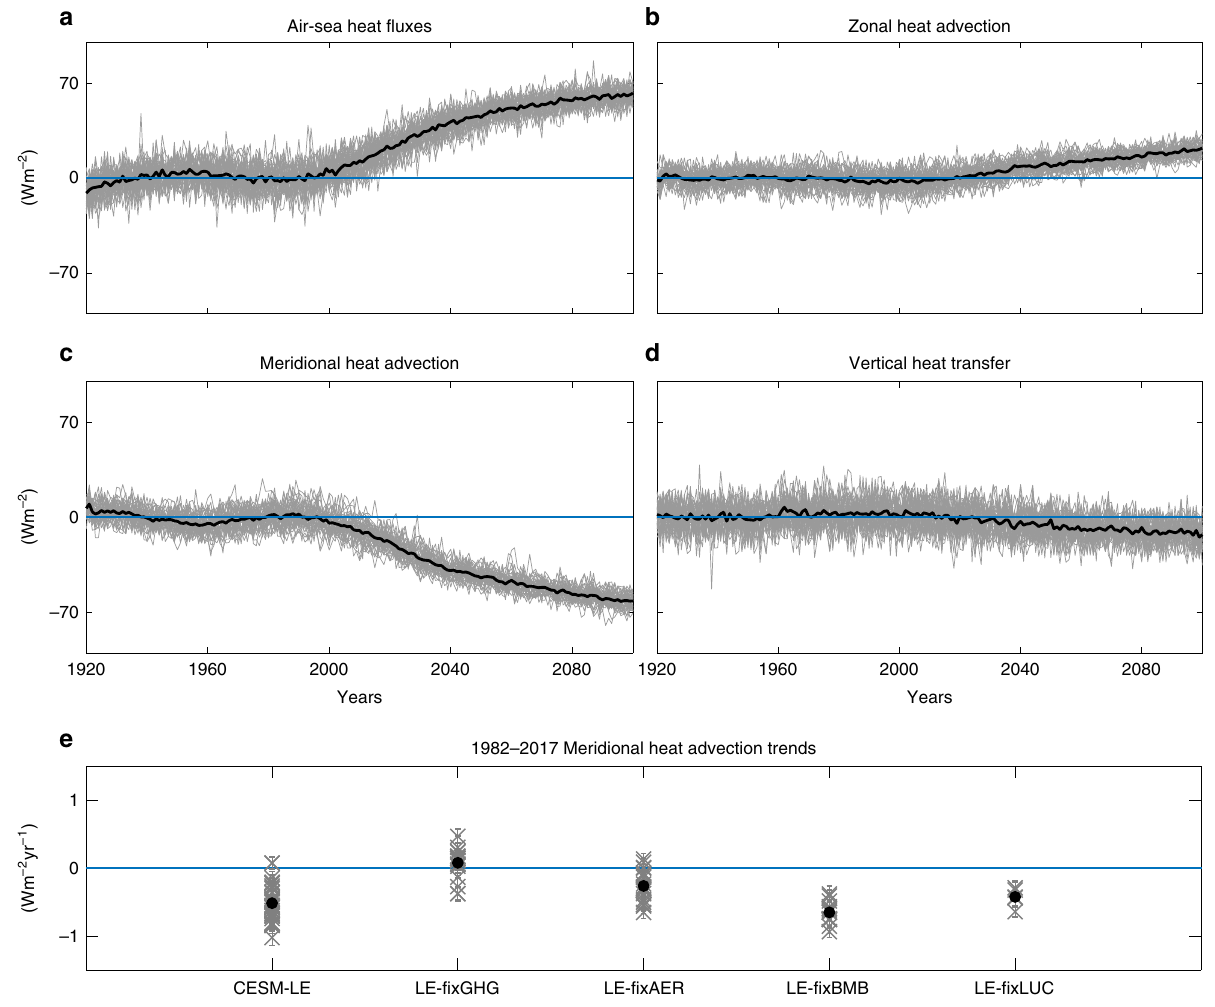
Fig. 4 Attribution analysis for the North Atlantic sea surface temperature fi ngerprint mechanism. The Community Earth System Model Large Ensemble (CESM-LE) annual mean mixed-layer temperature tendency equation anomalies (Wm − 2 , Eq. (1), Methods), relative to the 1920 – 1960 period, averaged over the warming hole region (see text); a Surface air-sea heat fl uxes. b Zonal heat advection. c Meridional heat advection. d Vertical heat transfers. The gray and black lines represent all CESM-LE members and their mean, respectively. e The 1982 – 2017 meridional heat advection trends in fi ve CESM ensembles with all forcing agents (CESM-LE), fi xed greenhouse gases (LE- fi xGHG), fi xed aerosols (LE- fi xAER), fi xed biomass burning (LE- fi xBMB), and fi xed land use/change (LE- fi